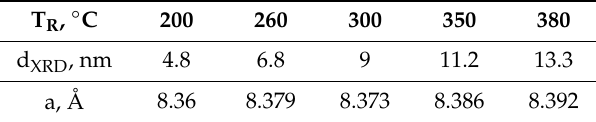
Table 1. The average crystallite size and lattice constants (a) of the samples synthesized at temperatures 200 ≤ T R ≤ 380 ◦